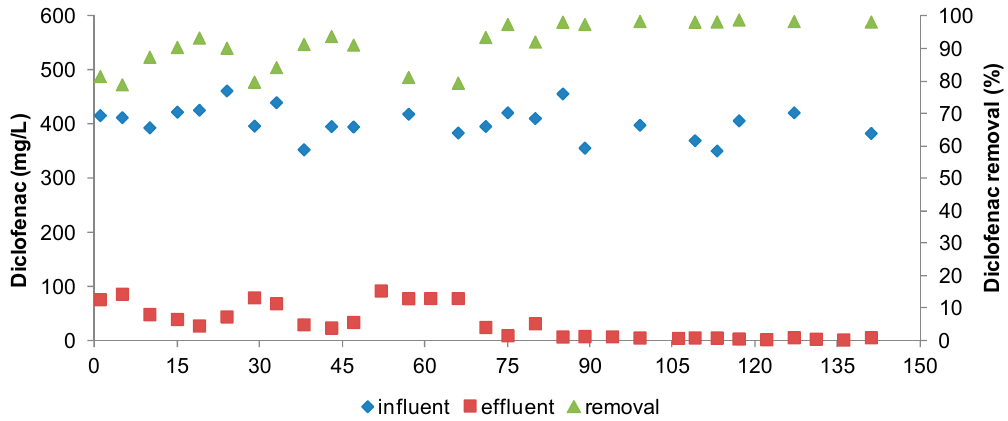
Figure 2. Diclofenac removal pattern in the immobilized cell biofilter treating diclofenac-based wastewater.